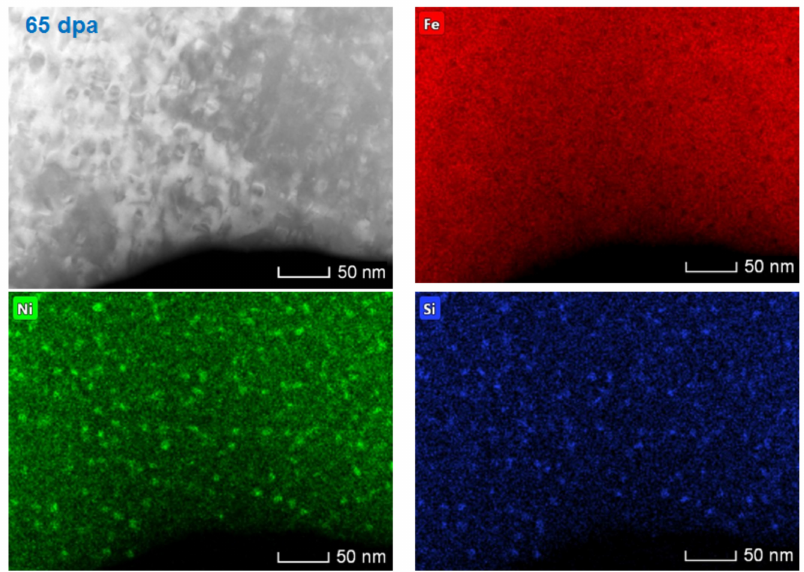
Figure 15. At high magnification spectral imaging of the 65 dpa material reveals marked co- segregation of Ni and Si as clusters or precipitates on the order of several nanometers in size (clock-wise from upper left: HAADF, Fe map, Si map, Ni